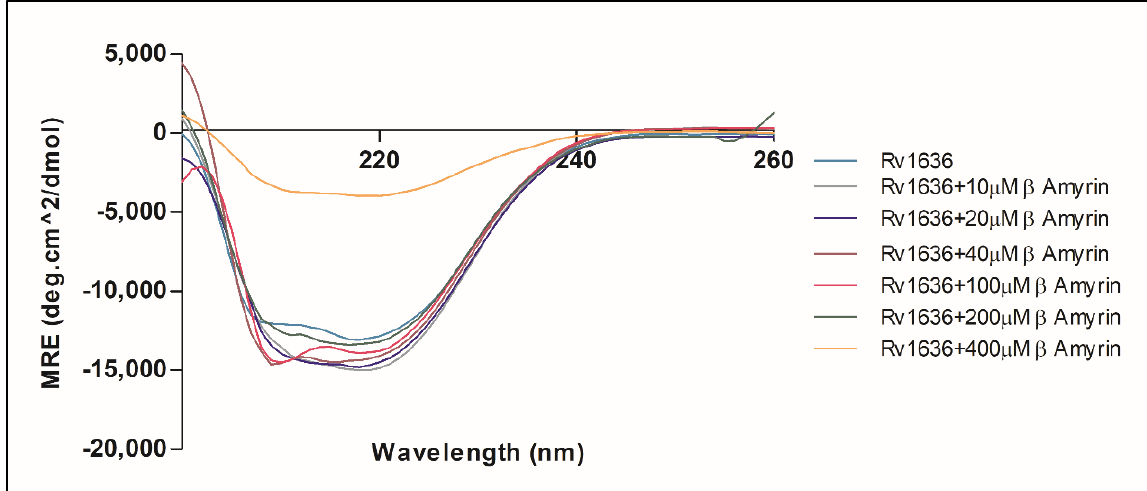
Figure 8. Far UV-CD spectroscopy to determine the secondary structure pattern of Rv1636 and the effect of β -Amyrin on Rv1636.